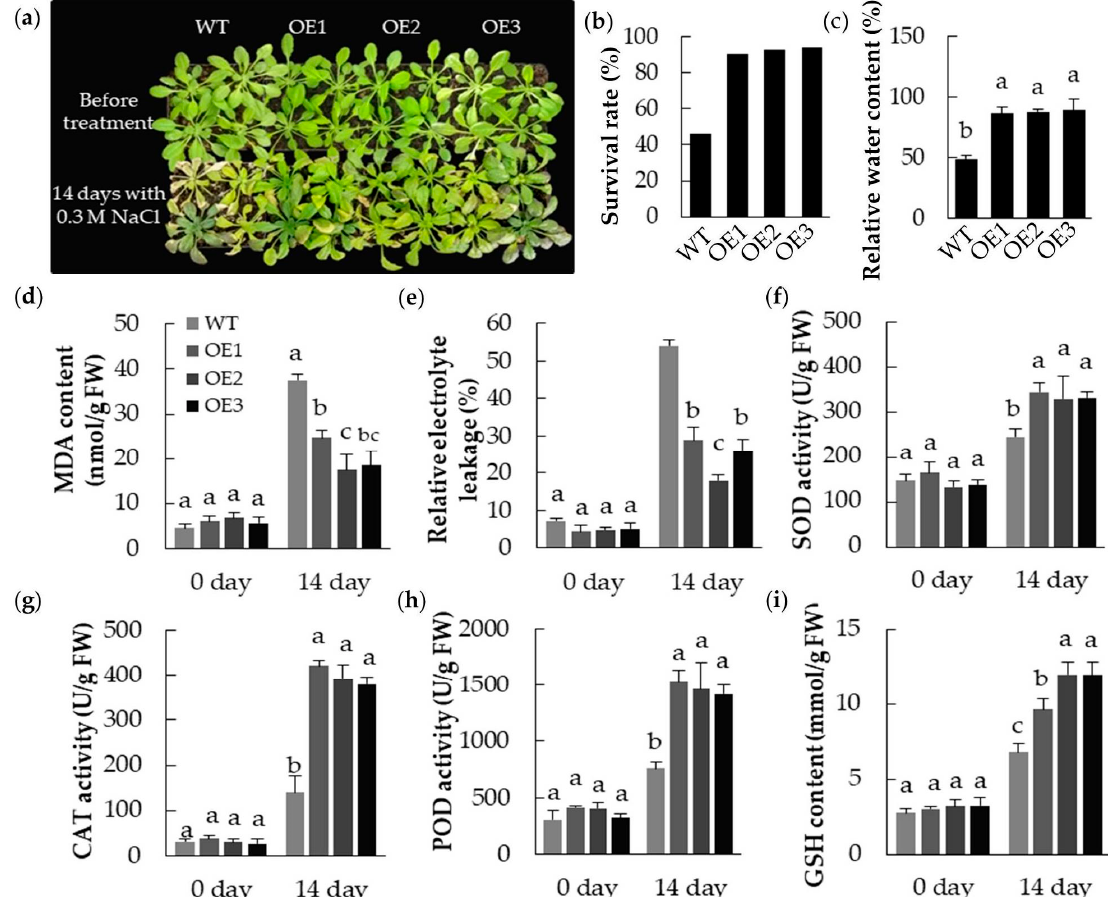
Figure 8. Heterologous expressing MpPIP2;1 enhanced salt tolerance in A. thaliana . ( a ) Phenotypes of transgenic lines and wild type plants treated with 0.3 M NaCl for 14 days; ( b ) Survival rate and ( c ) relative water content after exposure to NaCl; ( d ) MDA content; ( e ) relative electrolyte leakage; ( f ) SOD activity; ( g ) CAT activity; ( h ) POD activity; and ( i ) GSH content at 0 and 14 days after NaCl treatment. The value presented was the mean ± SD of three replicates, and the bar with different letter was significantly different between plants at p < 0.05.